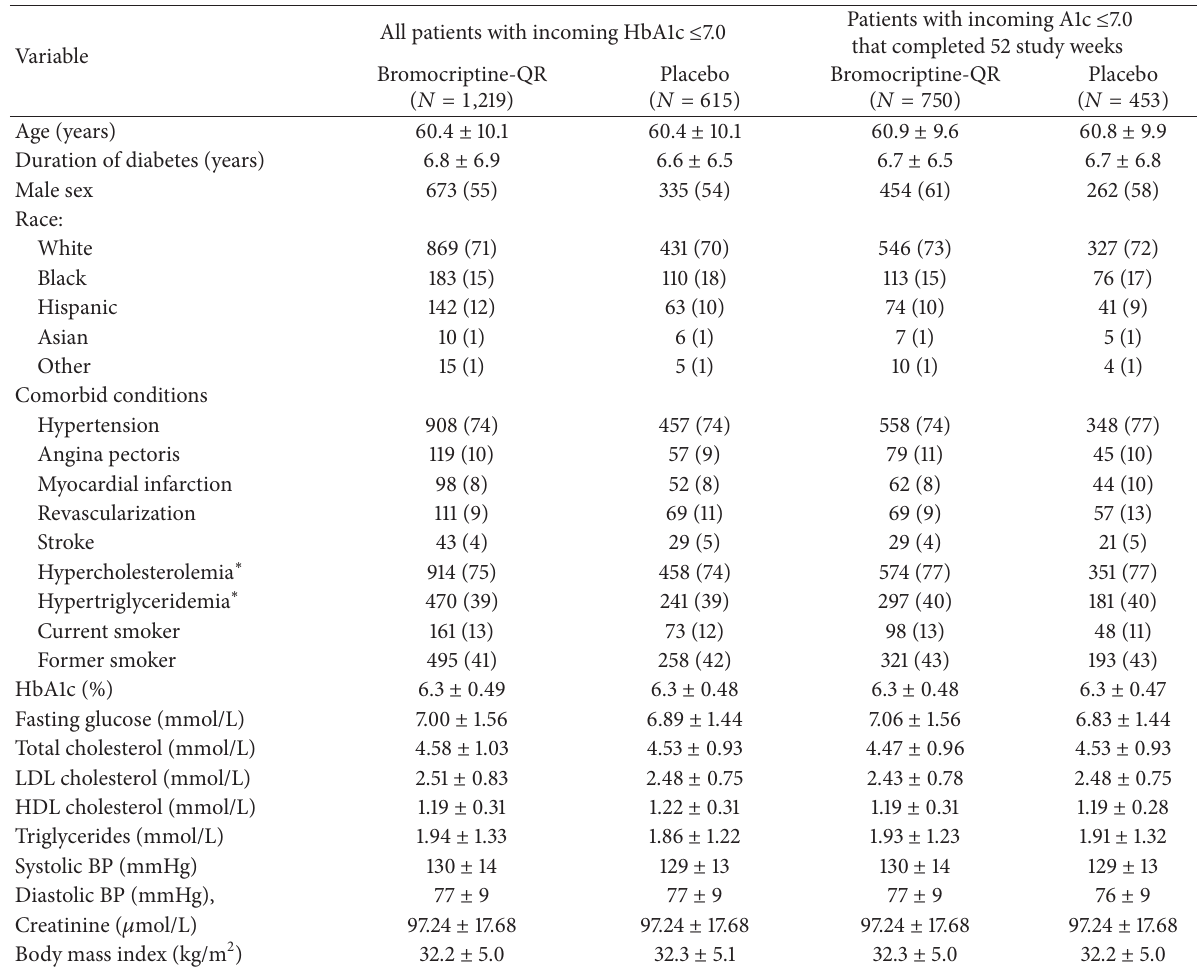
Table 1: (a) Baseline demographics, laboratory, and vital measures of study population. (b) Baseline antihyperglycemic and antihyperten- sive/cardioprotective medications of study population a